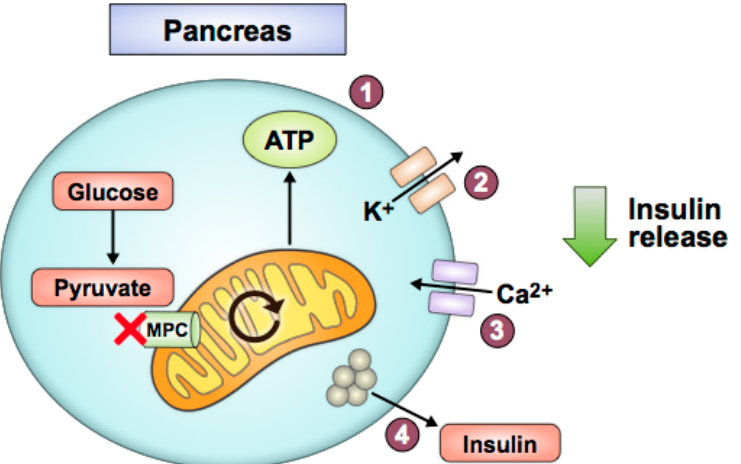
Pancreatic beta cell MPC disruption impairs glucose-stimulated insulin secretion. With decreased pyruvate-fueled mitochondrial ATP production (1), potassium-ATP channels stay open longer (2), and the cell does not depolarize as easily. Consequently, calcium influx is reduced (3), and insulin release does not occur as readily (4).